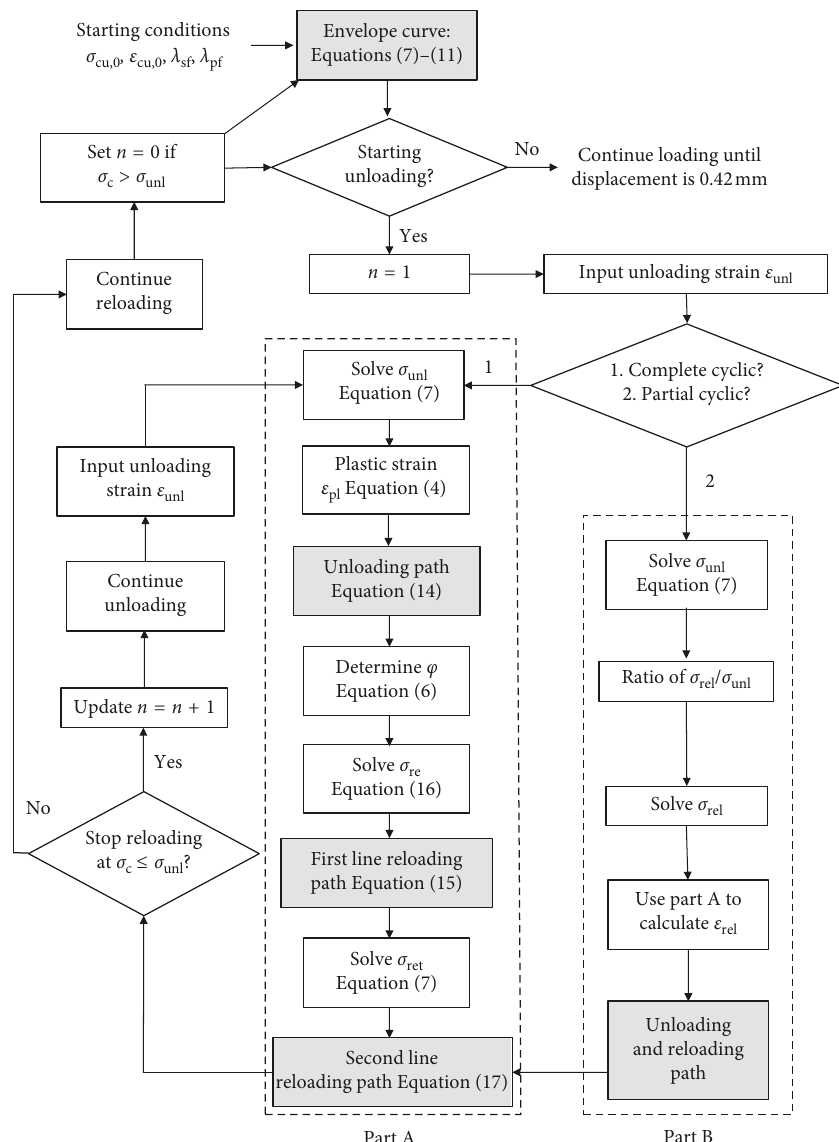
Figure 17: Flowchart describing the generation of stress-strain curves under cyclic